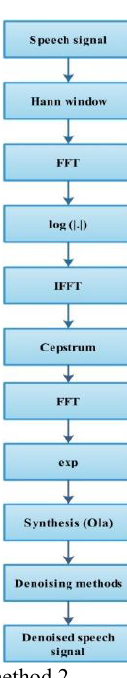
Fig. 5. Schema of hybrid method